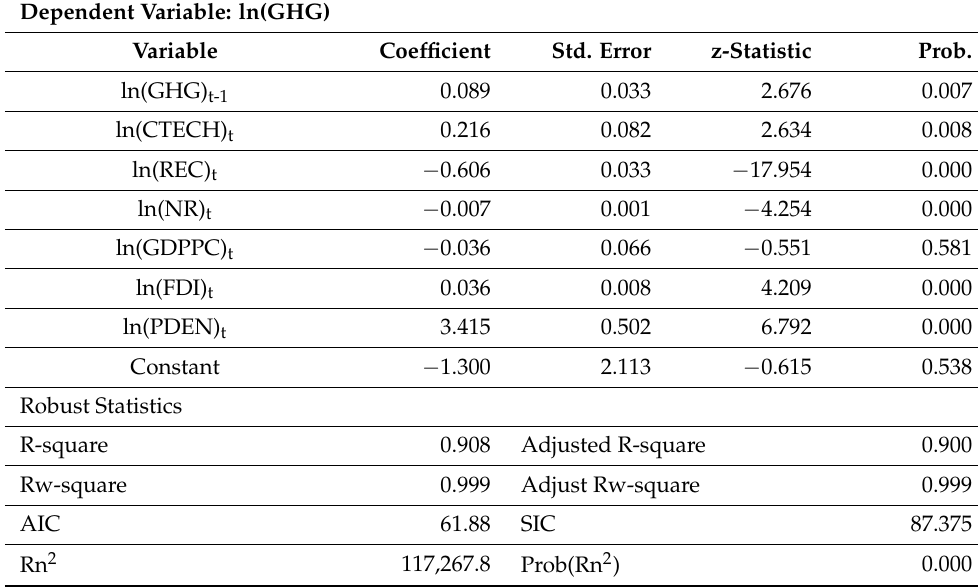
Table 6. Robust Least Squares